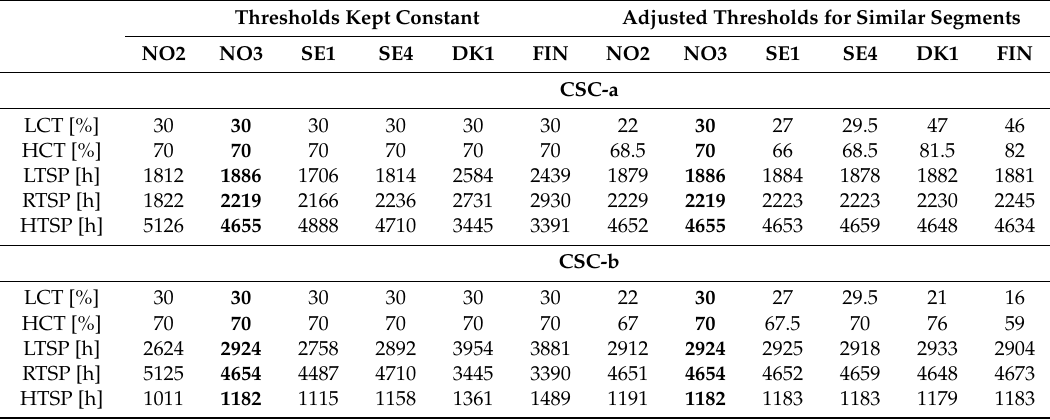
Table 4. Influence of the low-carbon and high-carbon thresholds (LCT and HCT) on the number of hours per temperature set-point segment (LTSP—low-temperature set-points; RTSP—reference temperature set-points; HTSP—high temperature